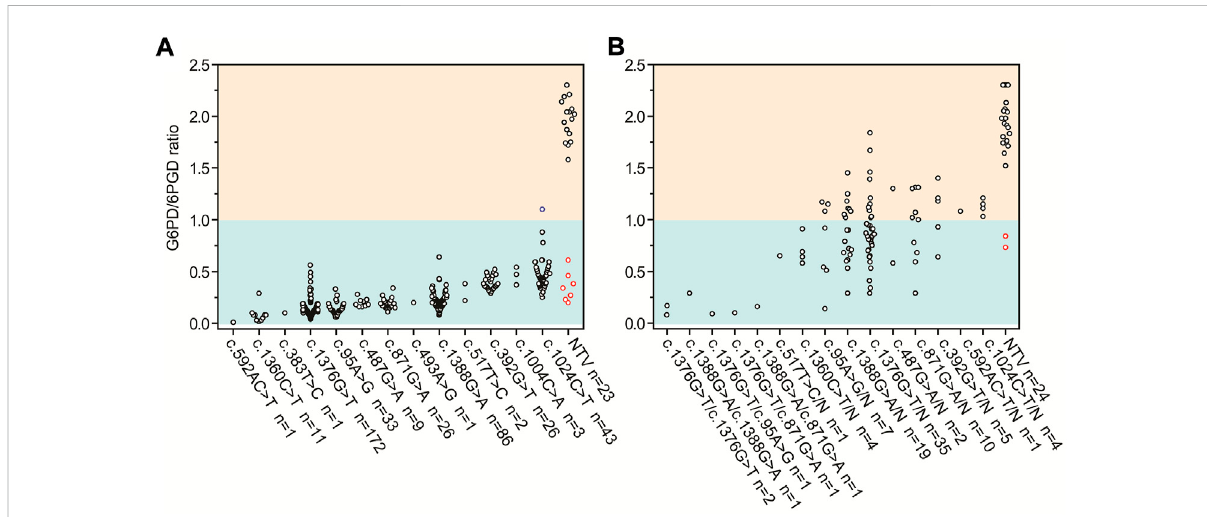
FIGURE 1 G6PD activities and targeted G6PD genotypes for (A) 437 male and (B) 118 female infants with positive newborn screening results. Red circles denote infants with G6PD activity de fi ciencies but negative for any of the target G6PD variants. Blue circle denotes the infant with the c.1024C > T variantandnormal G6PDactivity.G6PD, glucose-6-phosphatedehydrogenase;6PGD, 6-phosphogluconate dehydrogenase;n,number;N,normal allele; NTV, negative for target variants.